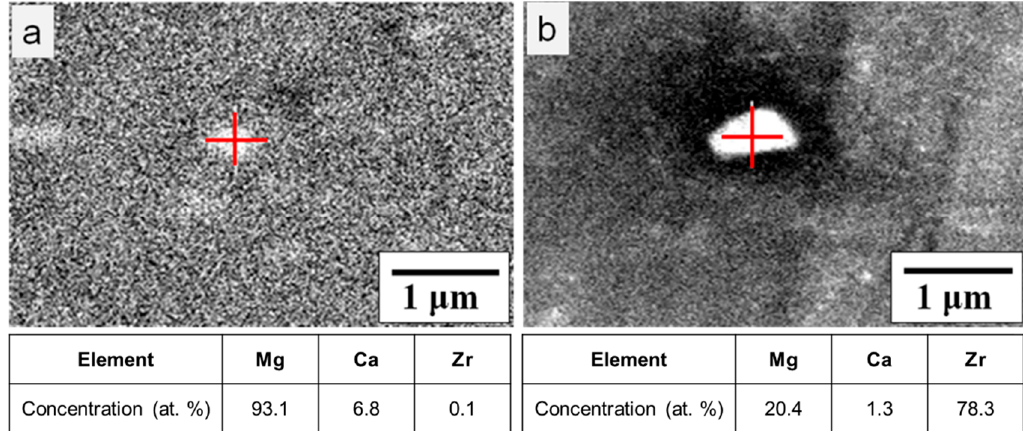
Figure 2. Secondary phase analysis of XK105-F using scanning electron microscopy (SEM) and energy-dispersive X-ray spectrometry (EDS). ( a ) Mg 2 Ca and ( b ) Zr particles.